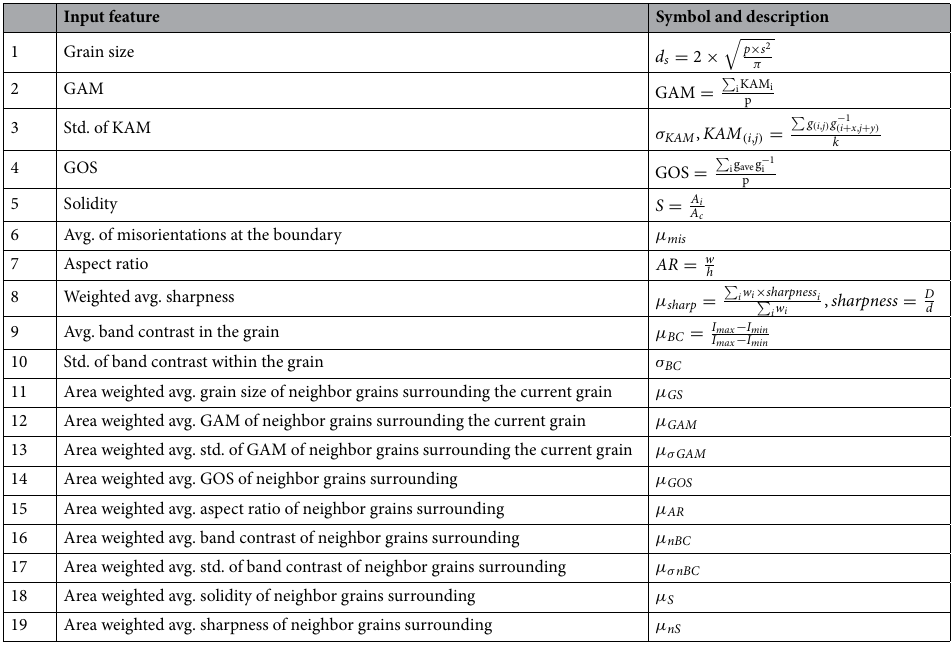
Table 3. Description of input features.